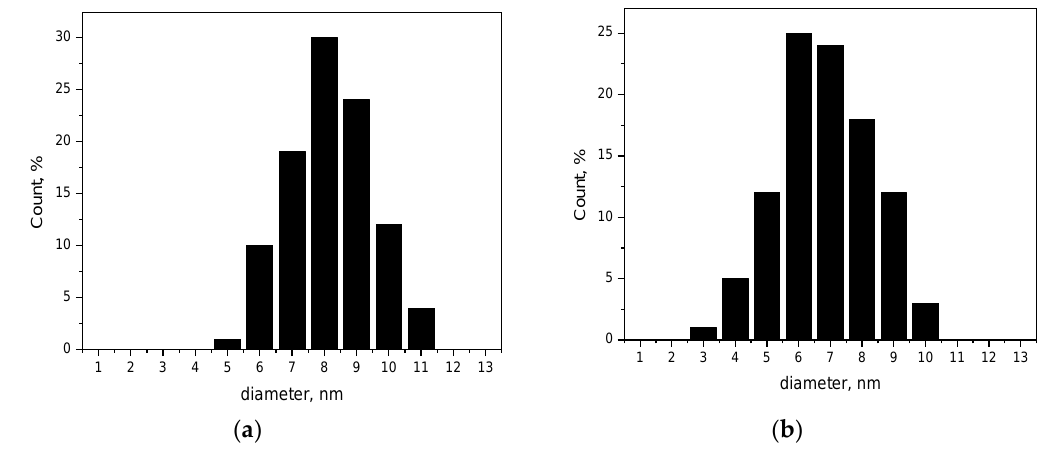
Figure 8. Diameter distribution of ( a ) CNF procedure I and ( b ) CNF procedure II.